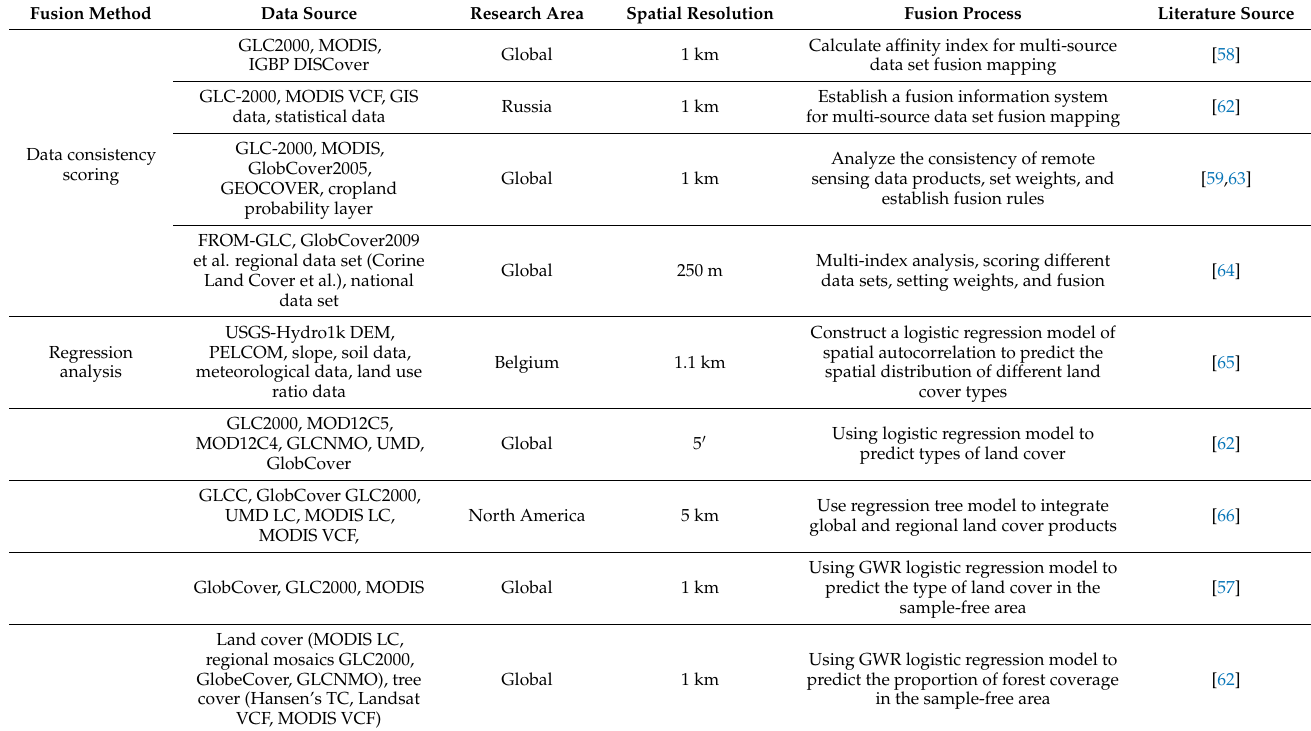
Table 3. Multi-source remote sensing data set synergy